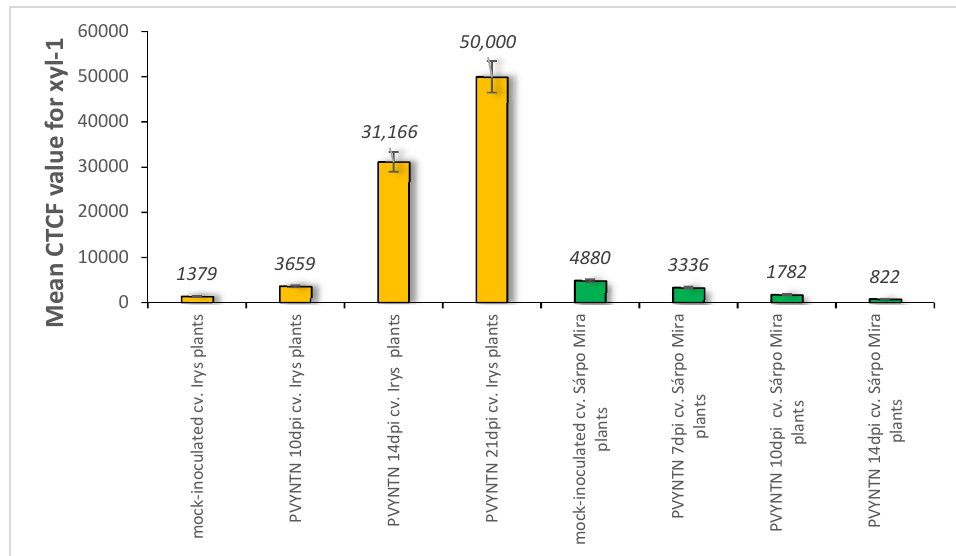
Figure 3. The assessment of the quantitative fluorescence signal of xylan-1/xyloglucan by using the corrected total cell fluorescence method (CTCF) with combination of ANOVA statistics analyses. Yellow bars indicate mock-inoculated and PVY-infected cv. Irys (susceptible) potato plants at 10, 14 and 21 days post-inoculation. Green bars represent mock-inoculated and PVY-inoculated Sárpo Mira (resistant) potato plants at 7, 10 and 14 days post-inoculation. Mean values CTCFC were evaluated at the p < 0.05 level of significance using post-hoc Tukey HSD test.